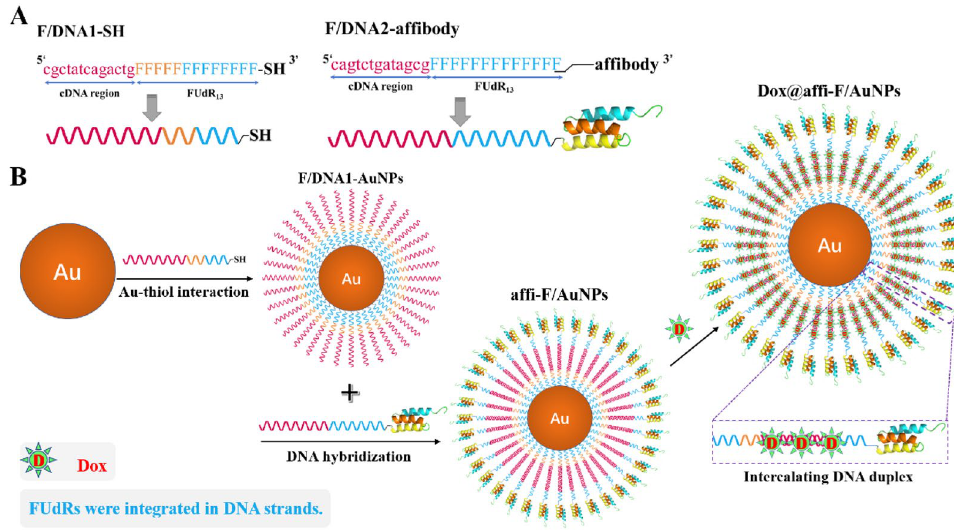
Scheme 1. (A ) Design of FUdR-containing DNA strands for construction of affi-F/AuNPs. ( B ) Schematic illustration of preparation process of